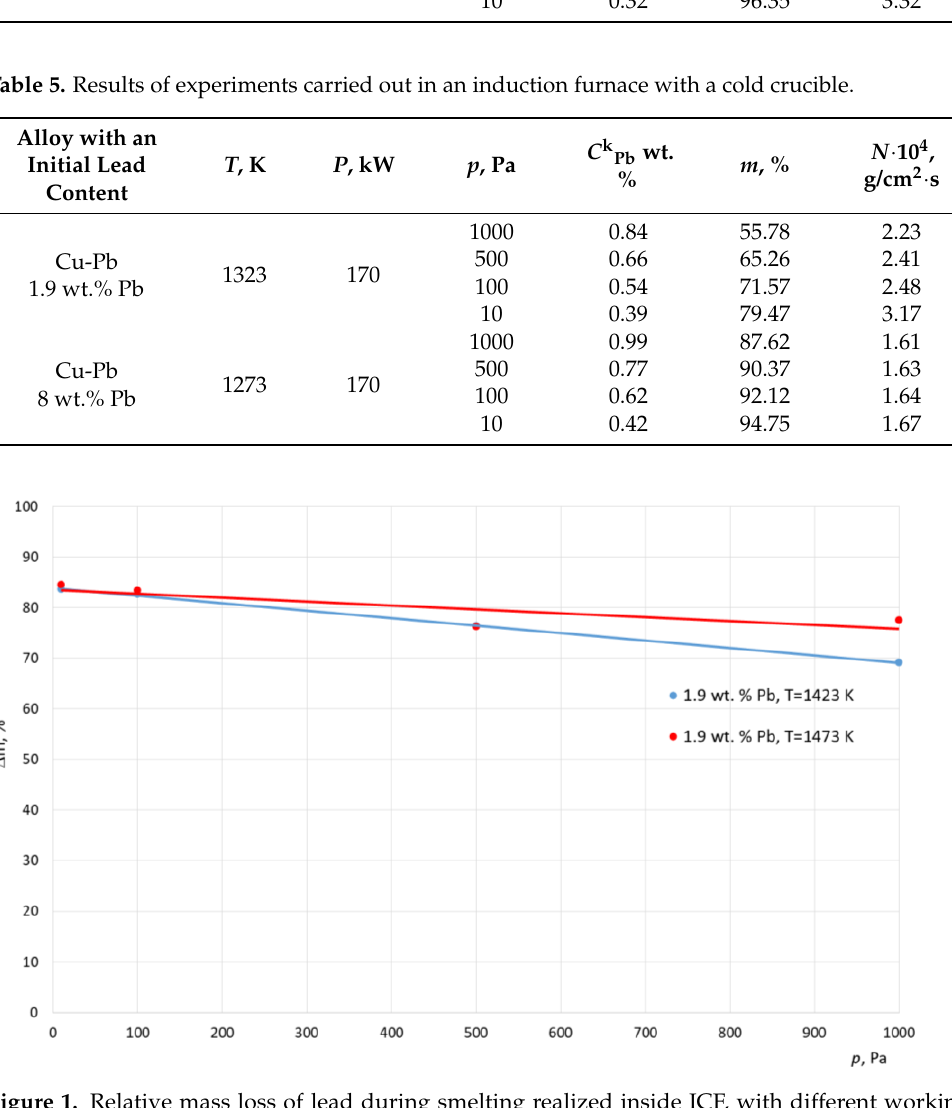
Figure 1. Relative mass loss of lead during smelting realized inside ICF, with different working pressures (alloy 1.9 wt. % Pb).